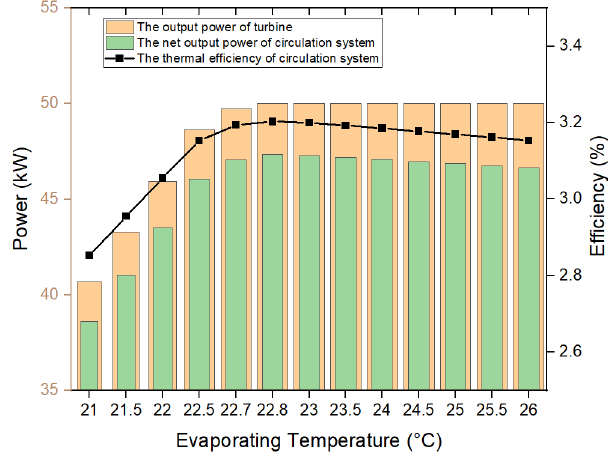
Figure 9. Thermal efficiency and output power of the circulation system.